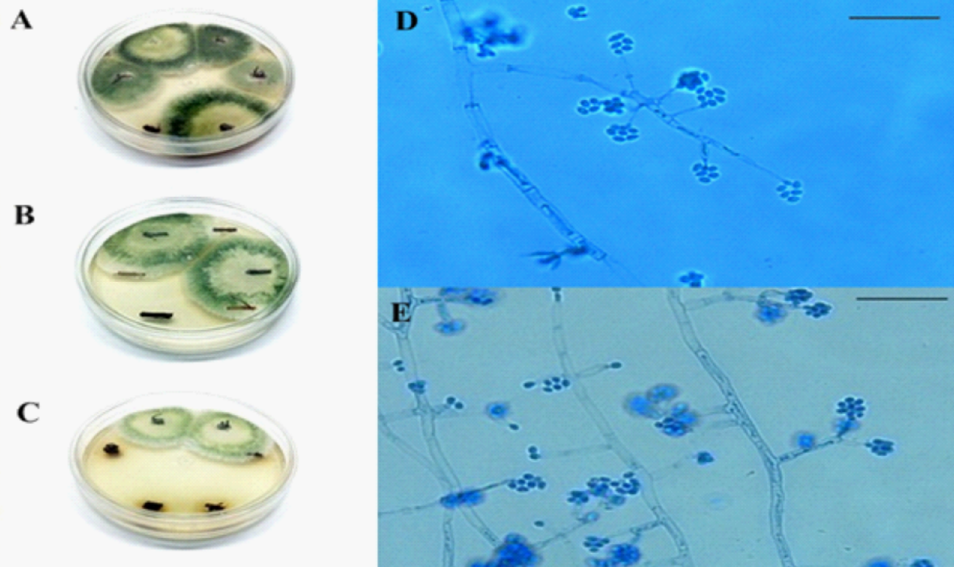
Figure 2. Endophytic colonization of Eucalyptus urophylla by Trichoderma strigosellum in ( A ): five root